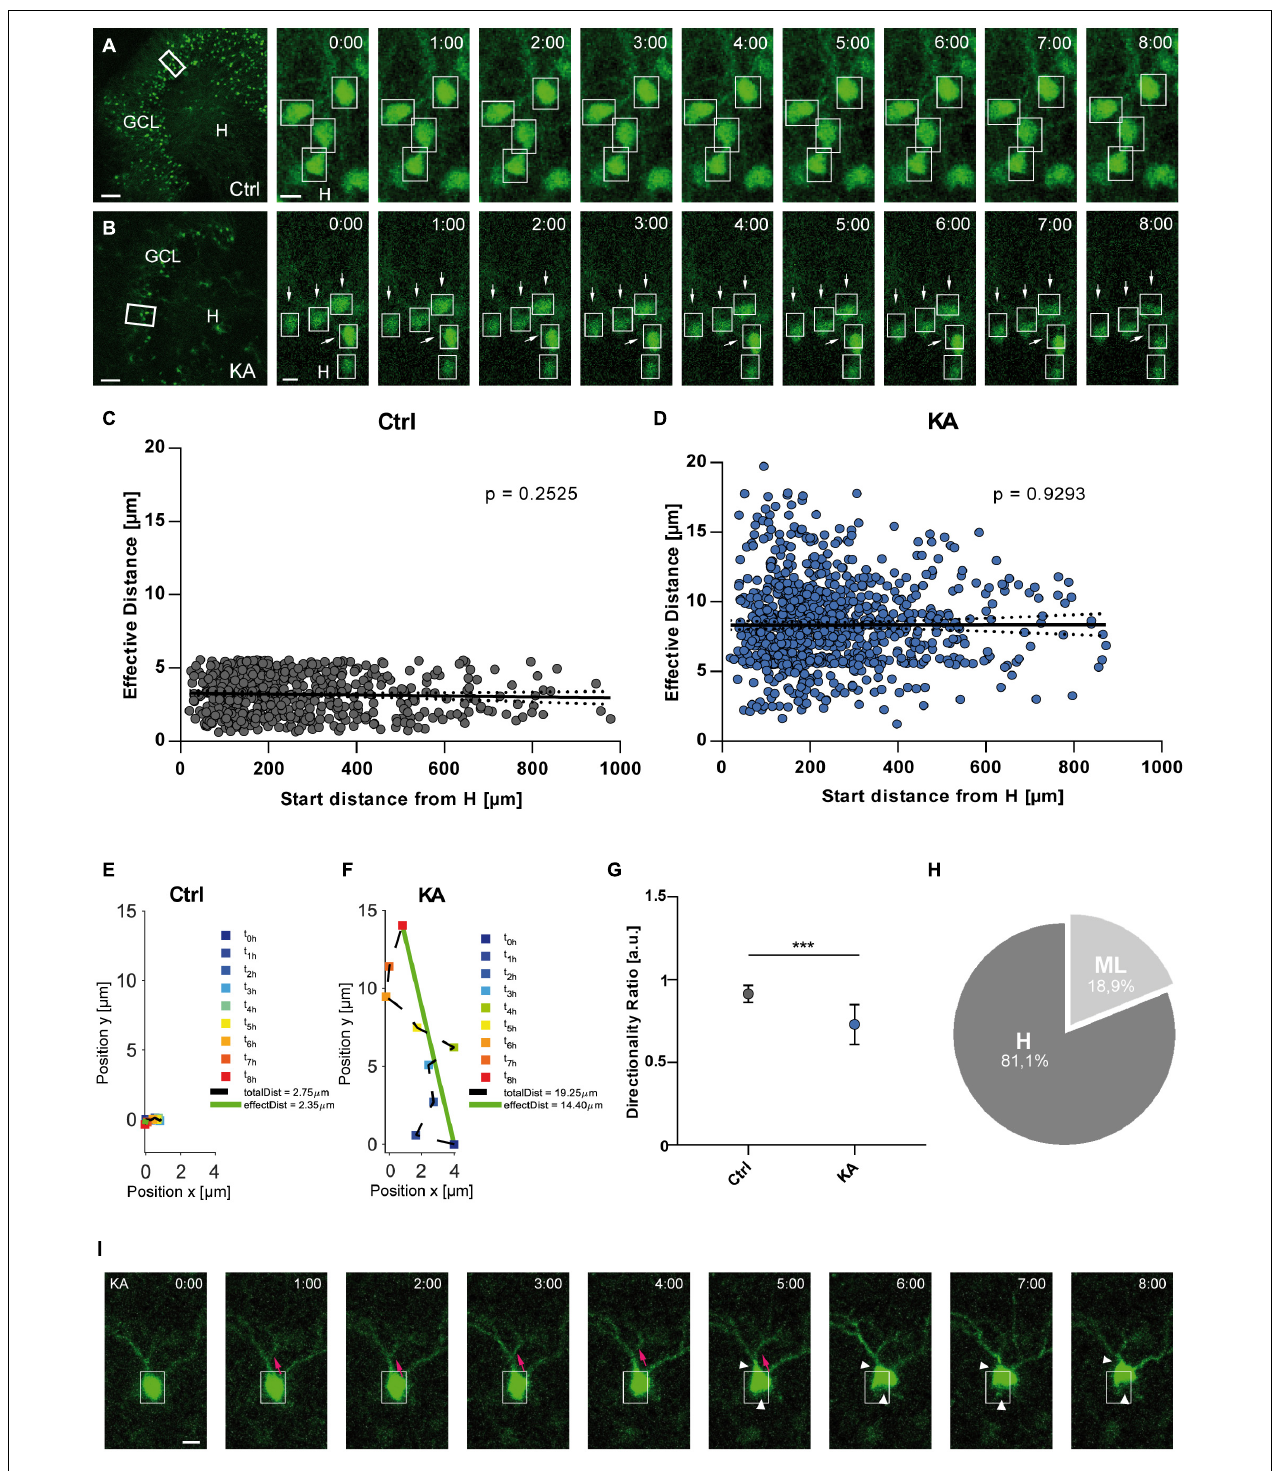
FIGURE 1 | EGFP-positive GCs migrate preferentially toward the hilus after KA treatment. Live cell imaging of individual eGFP-labeled GCs in control OHSC and after exposure to KA over a period of 8 h. (A,B) Representative confocal micrographs of nine imaging time points are shown for each condition. Left panel: overview; white frame indicates the area shown at high magnification on the right. Tracked cells are marked by white frames. (A) Untreated control. GCs do not change position. (B) Treatment with 10 µ M KA for 45 min. GCs with high motility are indicated by arrows. Scale bars: 80 µ m for overview; 10 µ m for high magnifications. (C,D) Quantitative evaluation of migration distances of individual GCs in controls ( C ; n = 23 slices, 548 cells) and in KA-treated OHSC ( D ; n = 20 slices, 868 cells).